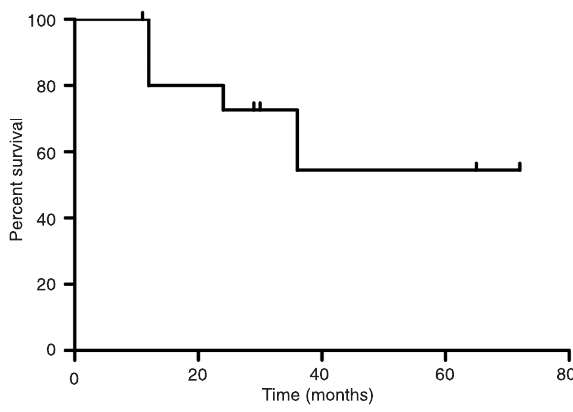
Figure 2. Kaplan-Meier curve of progression-free survival (PFS) rate for all 16 patients included in the